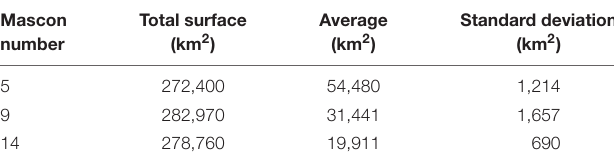
TABLE 2 | Description of the three mascon delineations.